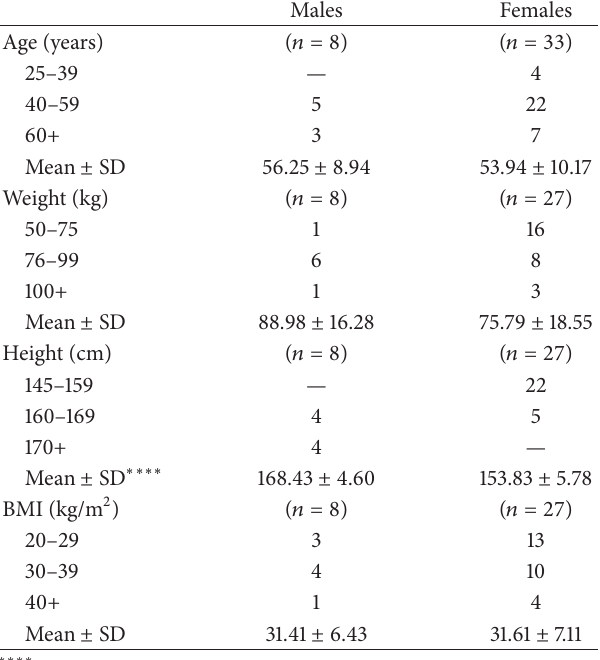
Table 1: En Balance study participant characteristics at baseline ( 𝑛 valid and missing cases = 46, 𝑛 missing cases for age = 5, 𝑛 missing cases for weight, height, and BMI = 9).